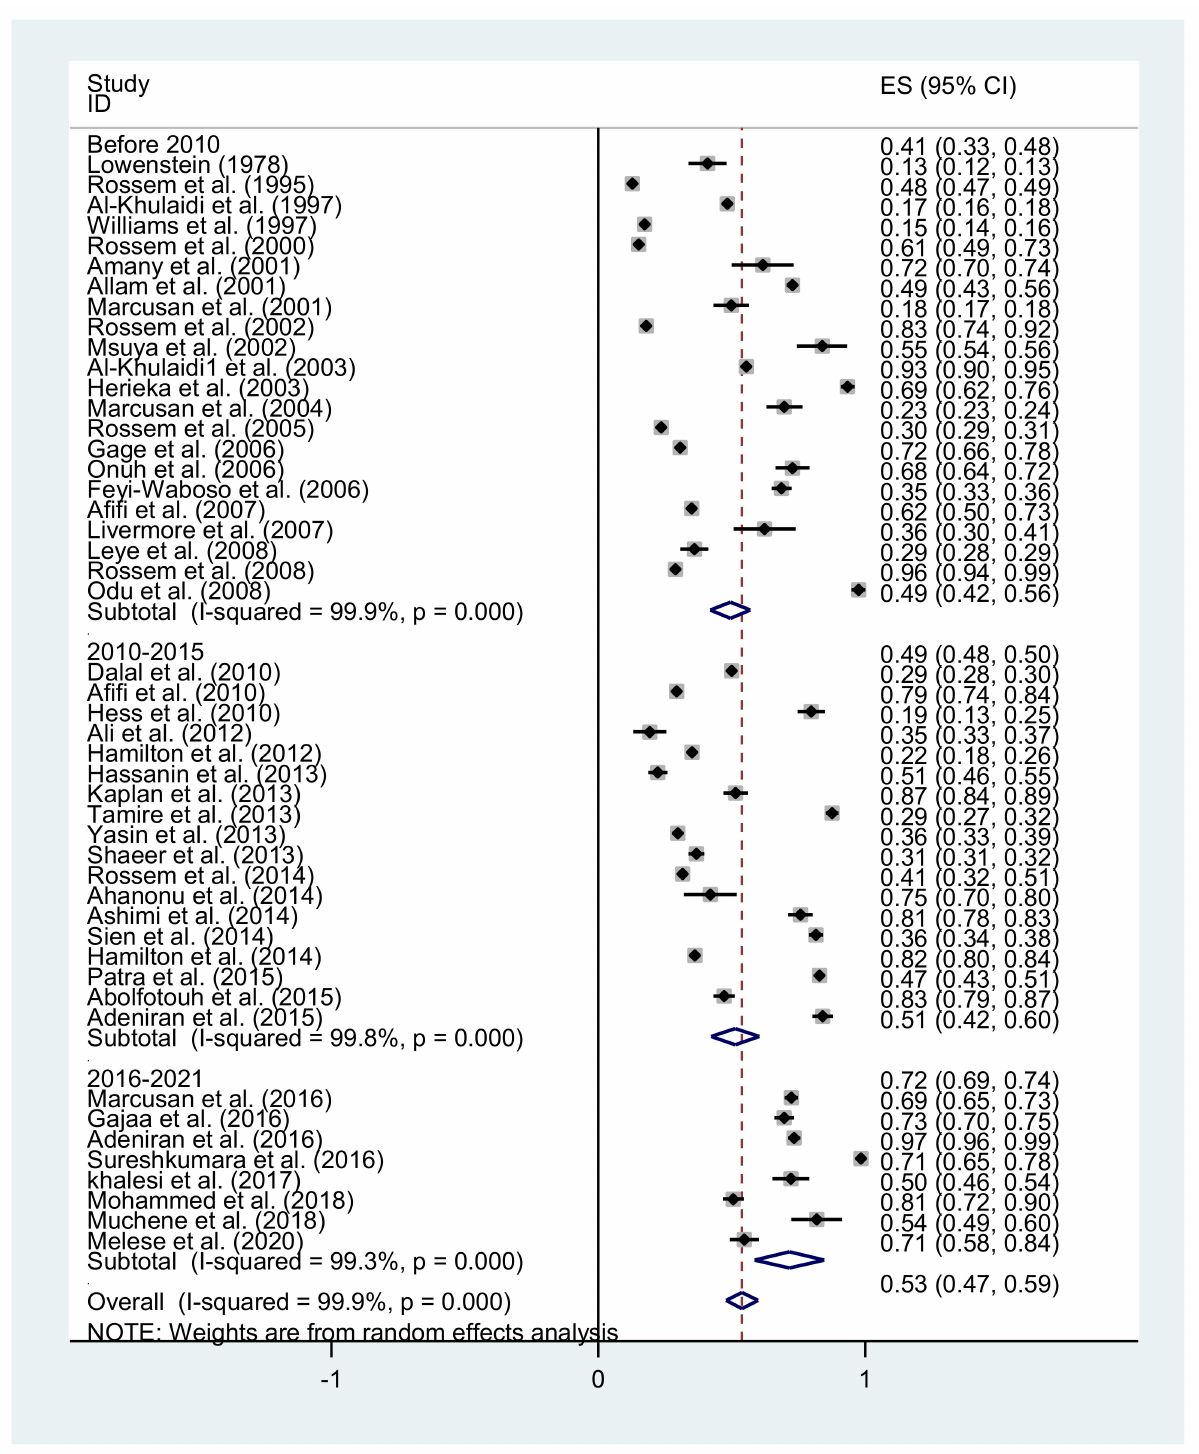
Figure 3. Negative attitudes toward FGM based on years categorizing. A forest plot of the studies included in the meta-analysis arranged by type of partici- pants and publication year is presented in Figure 4 ( I 2 99.9%, p = 0.001). Figure 5 provides a forest plot of the 18 studies that reported the proportion (%) of attitudes toward the decision not to circumcise daughters now or in the future, together with the 95% CIs. Overall, 63% (95% CI 46–80; p < 0.001) of the participants confirmed that they would not circumcise